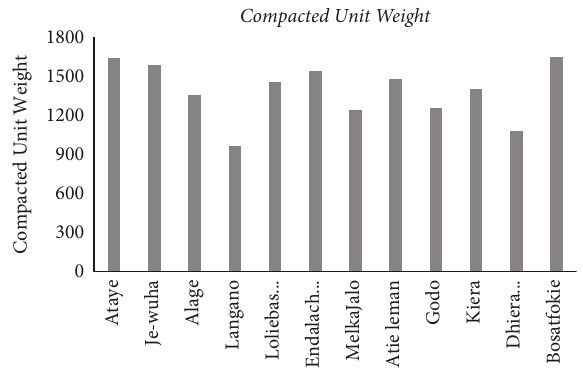
Figure 6: Compacted unit Wt. (source: test this